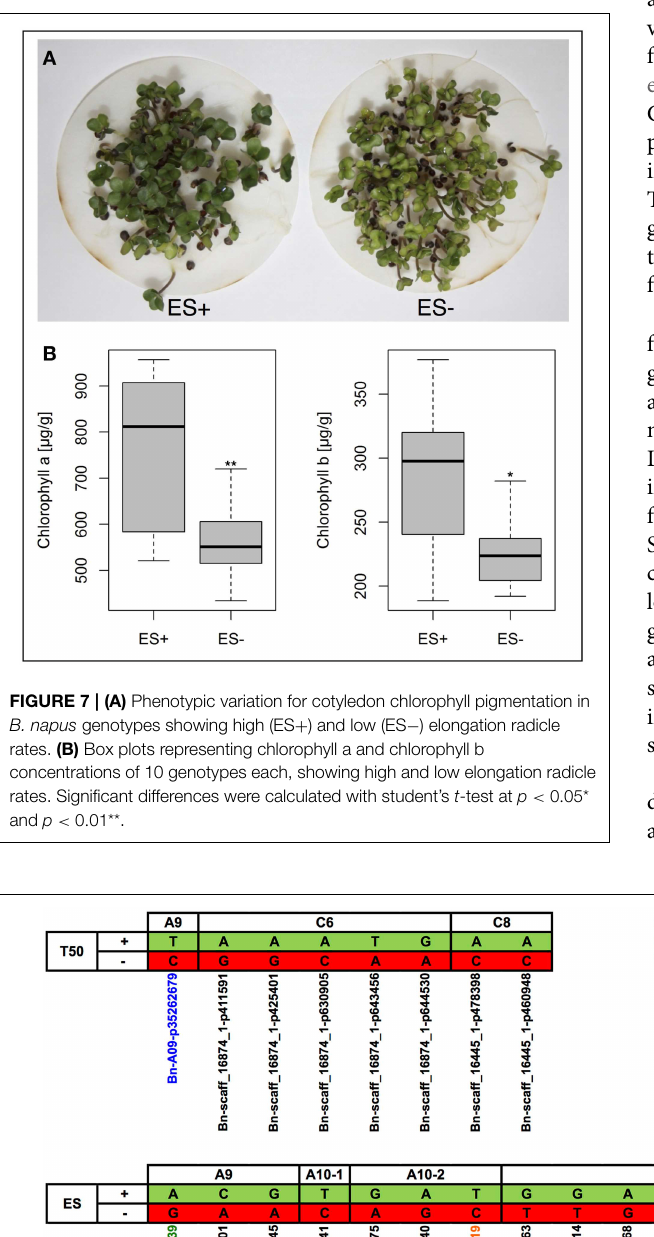
FIGURE 8 | Loci-specific alleles of single SNP markers and different haplotypes from LD-blocks harboring various SNP markers associated with T50 and ES. Favorable alleles ( + ) were marked in green,